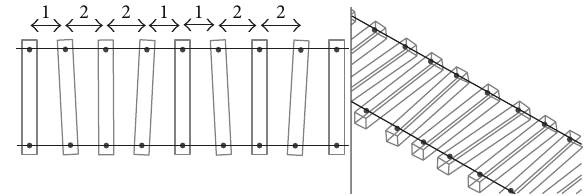
Figure 11: Track mistuning by the change of sleeper spacing (rotation of every second sleeper).